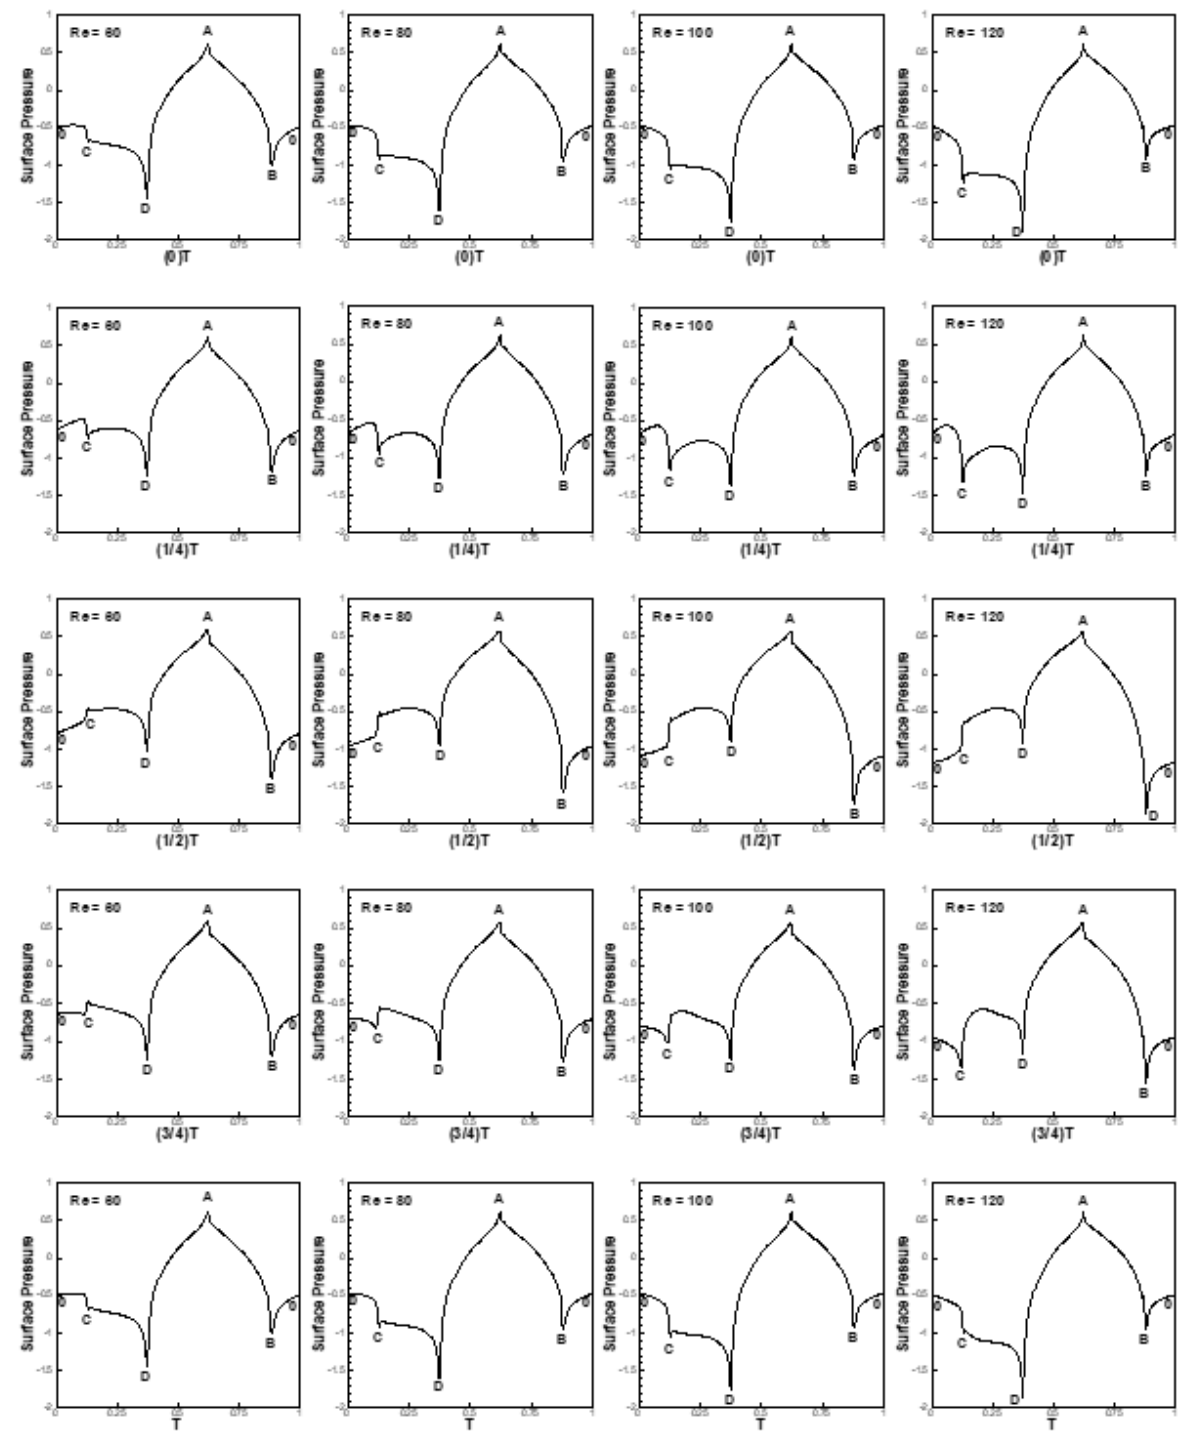
Figure 18. Pressure along the surface of cylinder at α = 45 °, Ri = 0.2 and 60 ≤ Re ≤ 120 for five successive moments of time that span over the whole period.